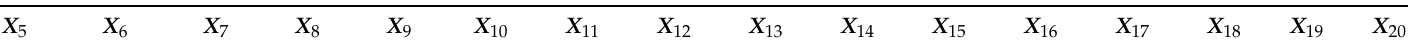
Table A3. Analysis of interaction effects of urban service-land area in